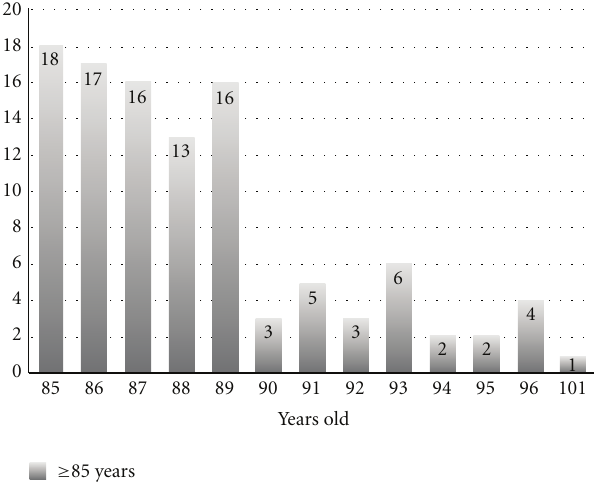
Figure 1: Distribution of patients according to age (Oldest Old